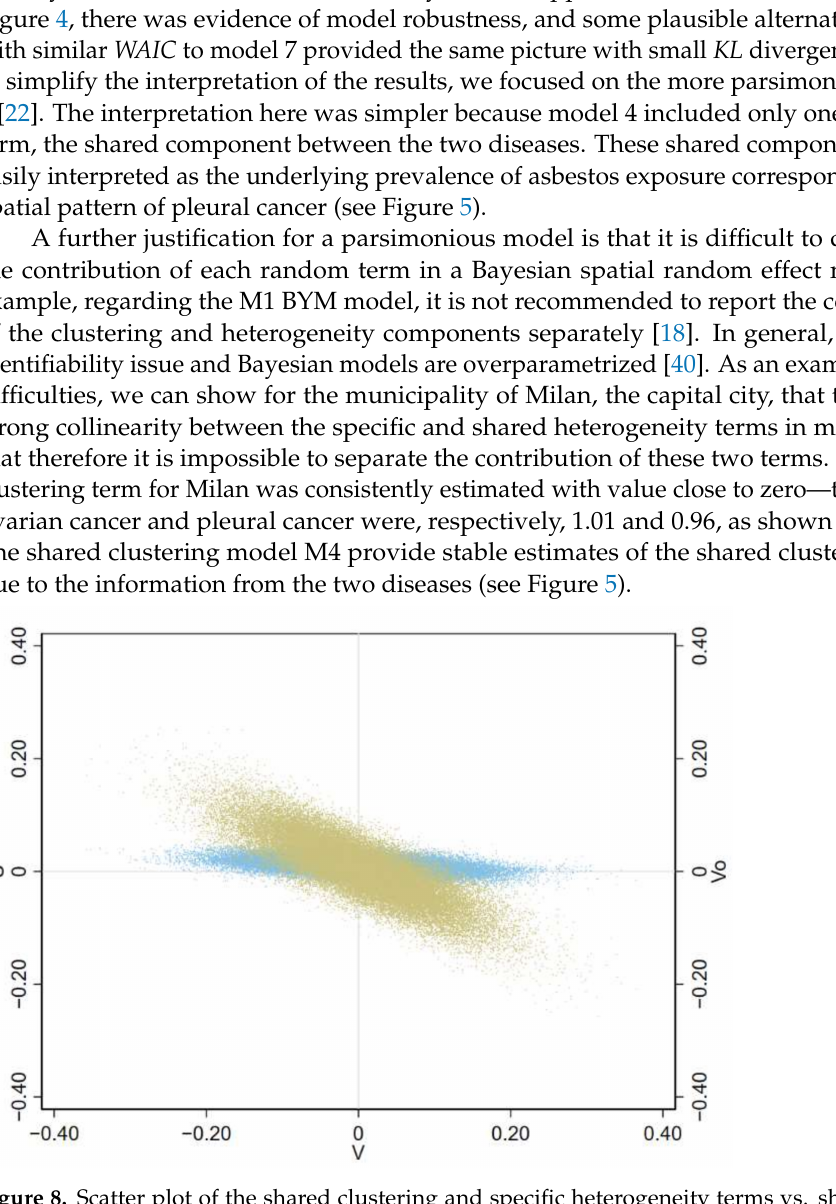
Figure 8. Scatter plot of the shared clustering and specific heterogeneity terms vs. shared hetero- geneity term of ovarian cancer from model 4 (M4) for the municipality of Milan. Lombardy Region, 2000–2018 (light blue: shared clustering; khaki: specific heterogeneity). Fifty thousand draws from the joint posterior